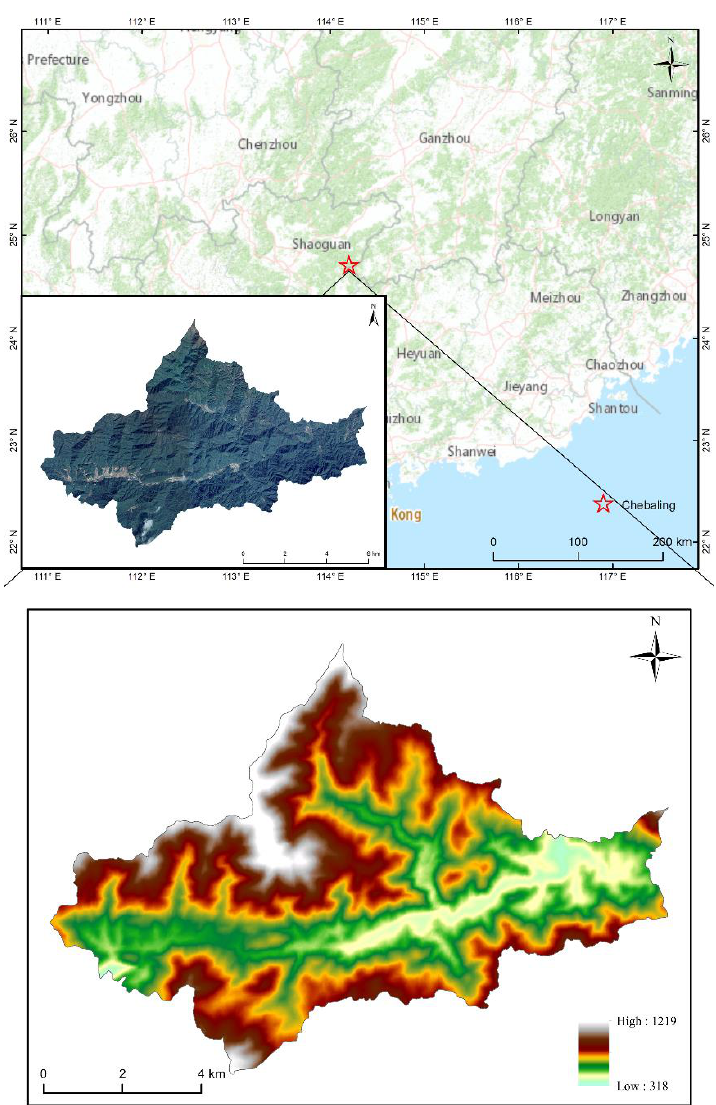
Figure 1. The map above represents the location and high-resolution remote-sensing image of Chebaling (the red star represents the central point of Chebaling; the GF-1 remote-sensing image had a resolution of 2 m and was acquired on 15 February 2017); the map below shows the DEM of Chebaling.